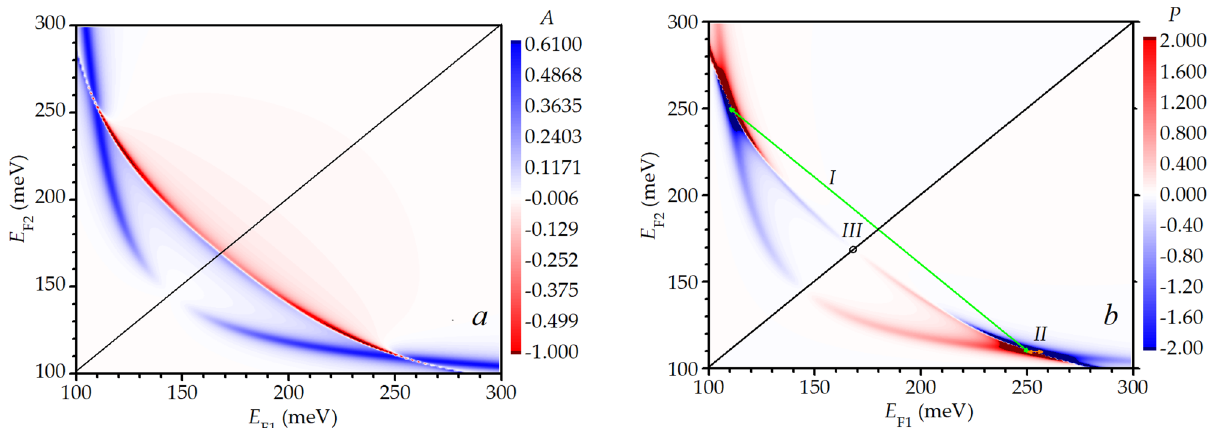
Figure 2. Absorption coefficient of the incident electromagnetic wave ( a ) and transformation coefficient of the incident wave into the propagating plasmon. ( b ) in the DGGGH in dependence on the Fermi energy values in the gated regions of the upper graphene. Plasmon direction switches of different types are denoted by I and II . Excitation of the standing plasma wave for symmetric DGGGH is shown by point III.